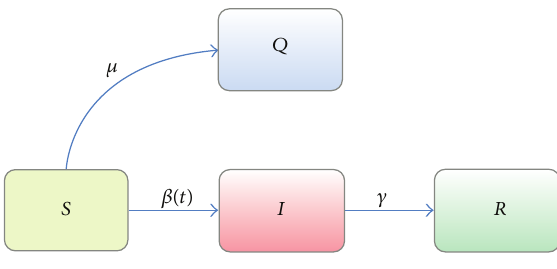
Figure 3: State transition of TF mode.